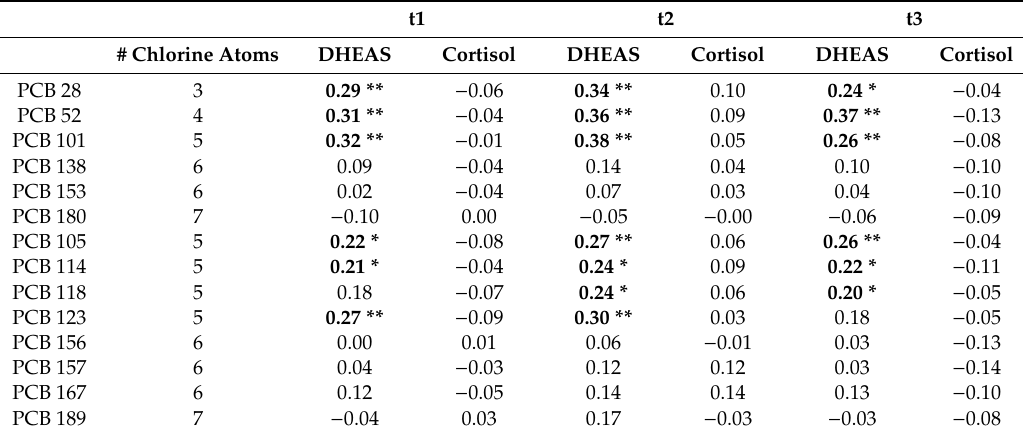
PCB 189 7 − 0.04 0.03 0.17 − 0.03 − 0.03 − 0.08 Note: PCB = polychlorinated biphenyl; DHEAS = dehydroepiandrosterone sulfat; t1–t3 = sampling